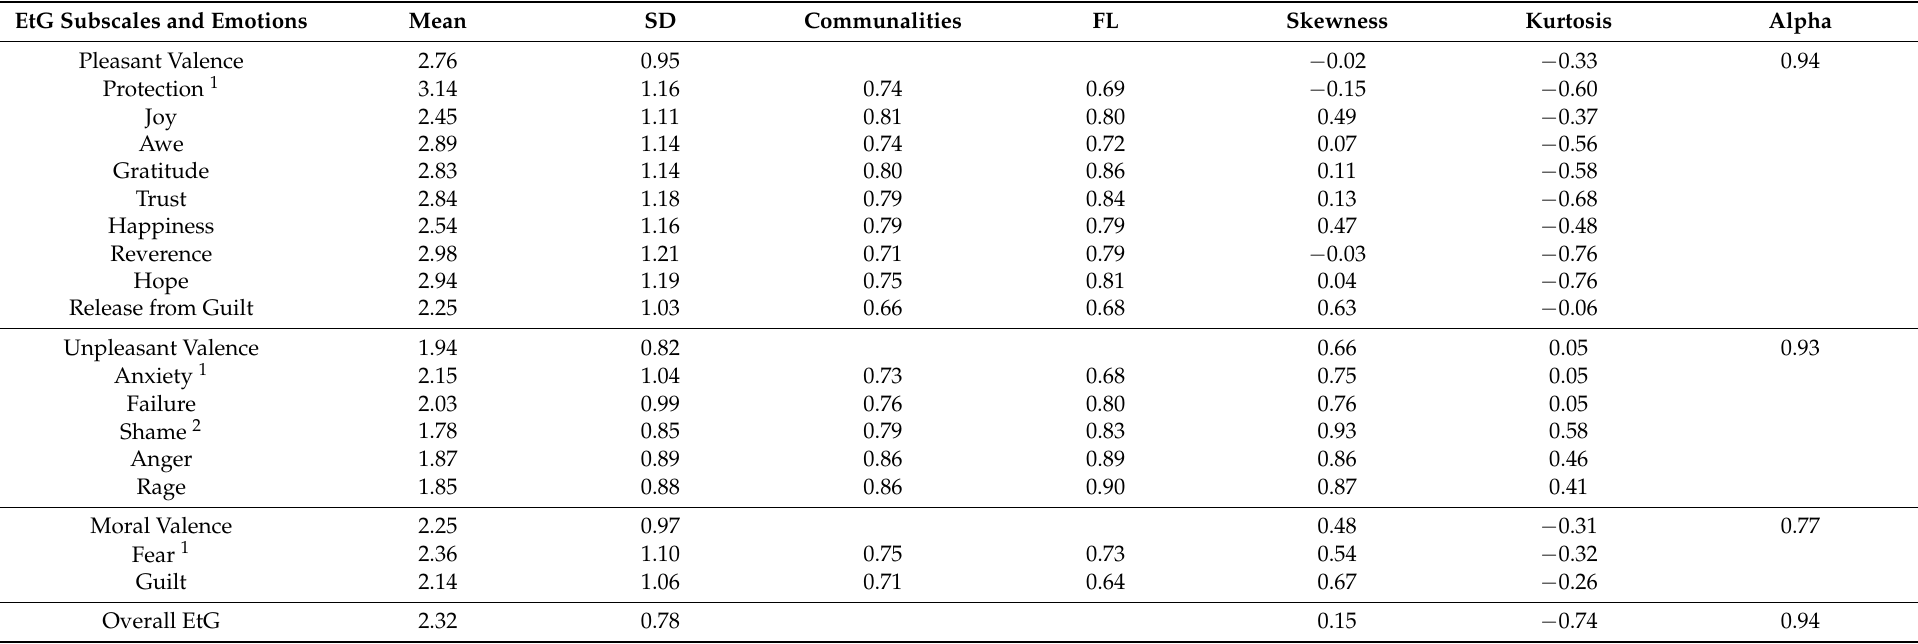
Table 3. Descriptive statistics, communalities, factor loadings, and alpha reliabilities of EtG